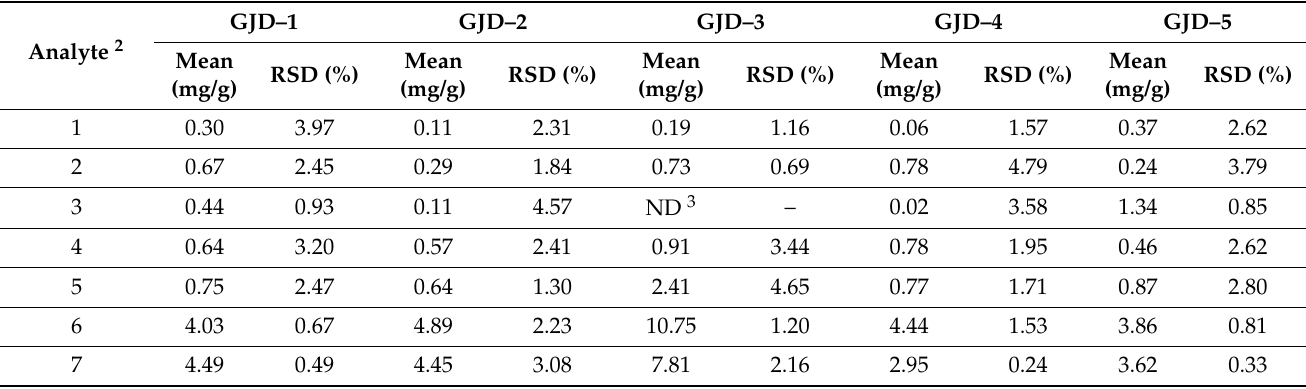
Table 7. Amounts (mg/g) of the seven analytes in GJD–1 to GJD–5 samples determined using